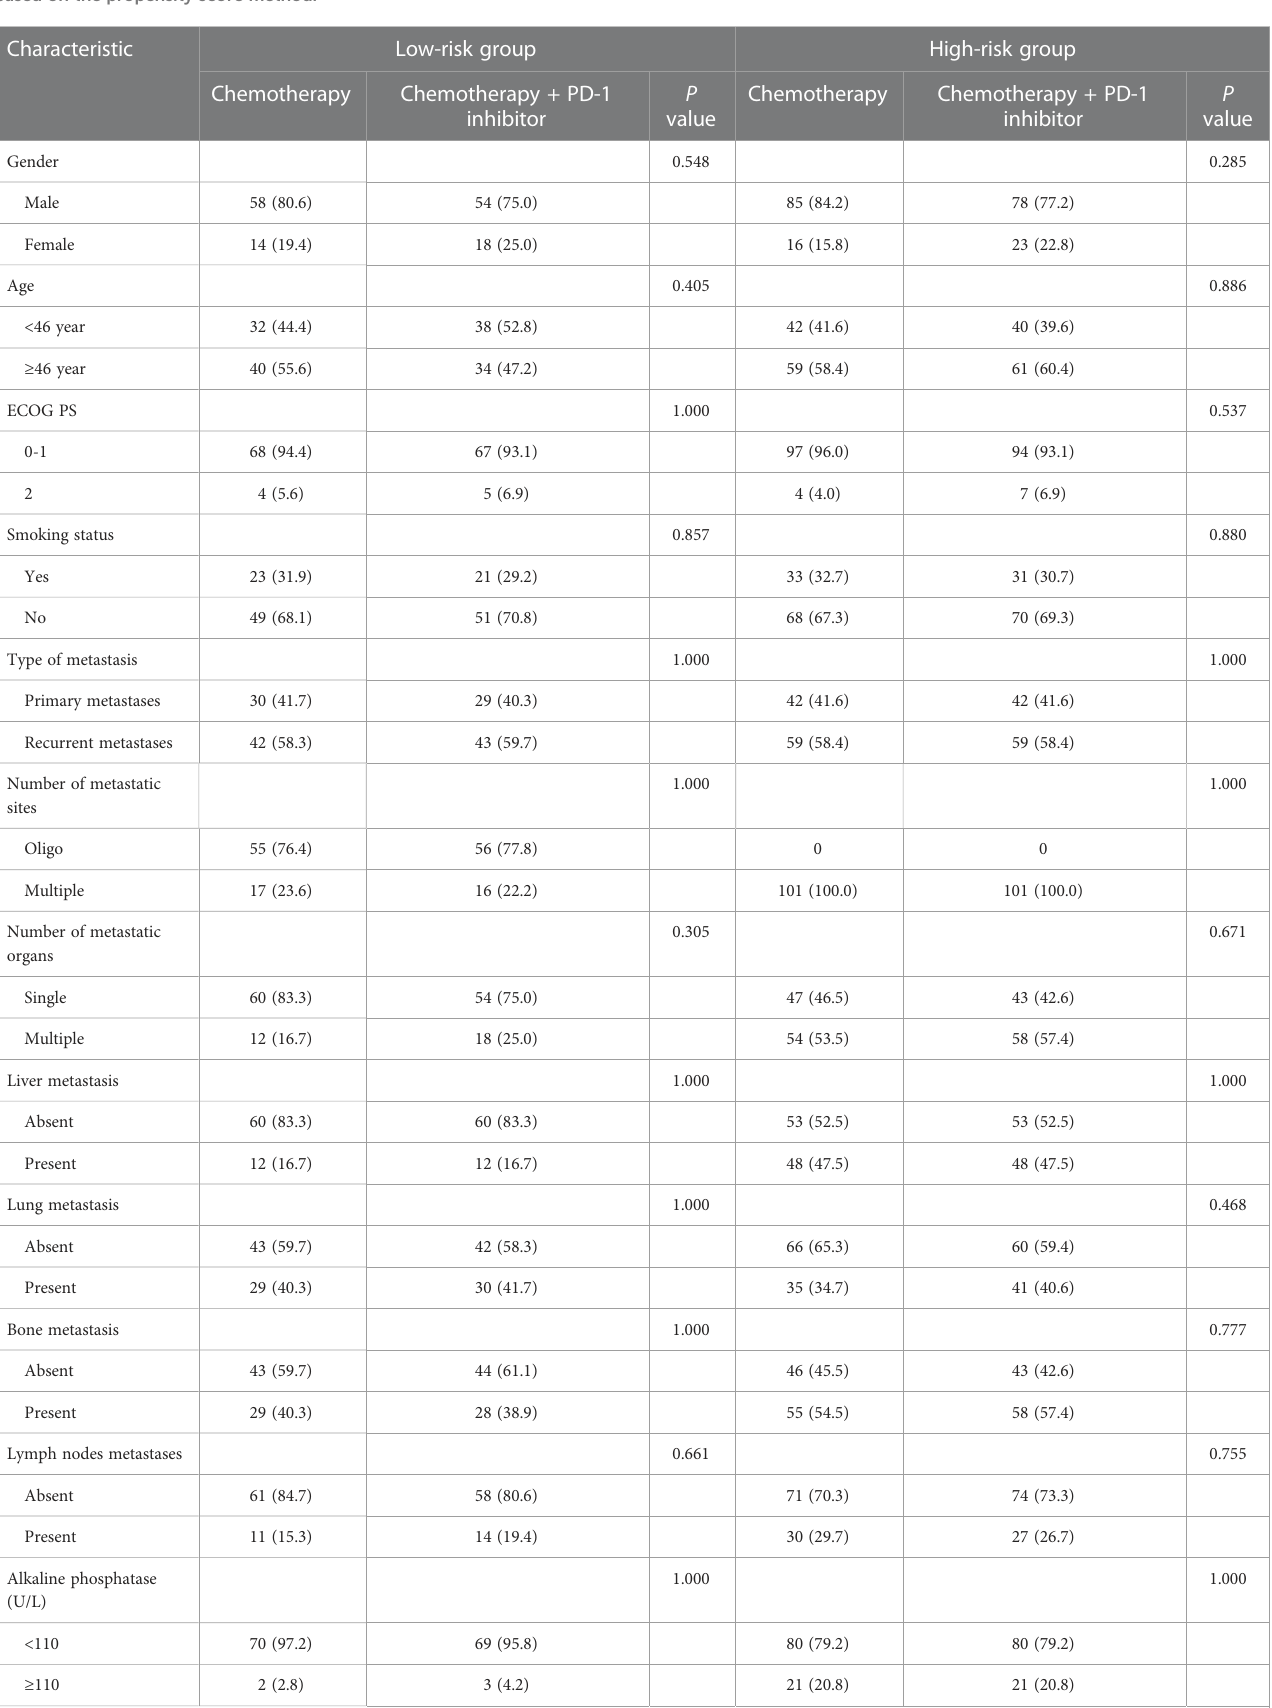
TABLE 2 The baseline characteristics of the patients treated with chemotherapy combination PD-1 inhibitor or chemotherapy alone in each risk group based on the propensity score method.